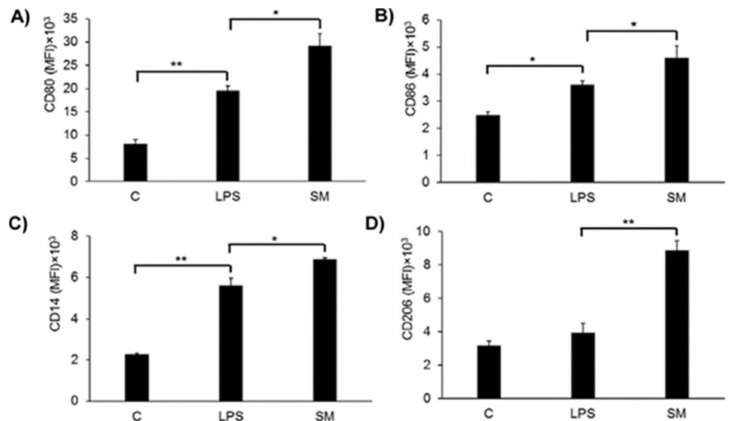
Figure 7. E ff ect of SM on the expression of cells surface markers CD80 ( A ), CD86 ( B ), CD14 ( C ), and CD 206 ( D ). Cells were incubated with LPS (1 µ g / mL) or SM (0.5 µ M) for 24 h and stained with specific antibodies. The expression levels of specific surface molecules are presented in terms of mean fluorescent intensity (MFI). In the all experiments, non-treated cells was used as a control (designated by C). Values are expressed as the mean ± SD of the three independent experiments. * p < 0.05, ** p <